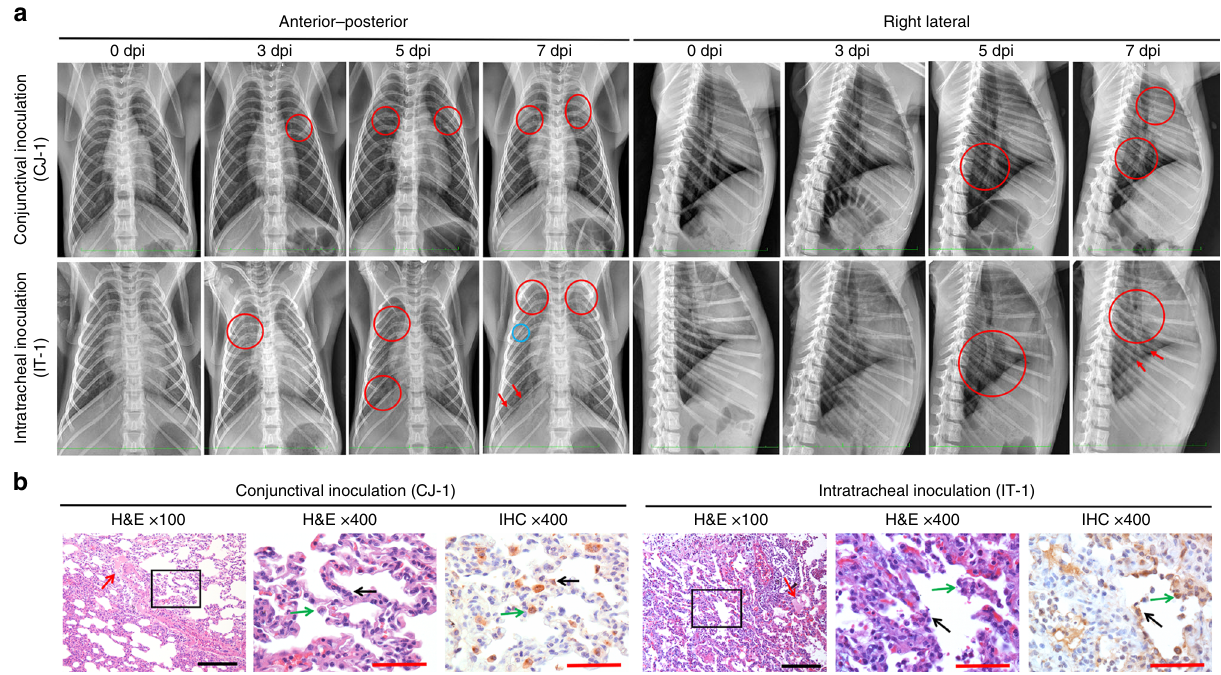
Fig. 3 Comparison of lesions in the lungs of CJ-1 and IT-1. Anterior – posterior and right lateral chest radiographs ( a ) were collected from rhesus macaques prior to SARS-CoV-2 inoculation (day 0) and at 3, 5, and 7 dpi. Areas of interstitial in fi ltration, indicative of pneumonia, are highlighted (red circle); obscure costophrenic angles (red arrows) and patchy lesions (blue circle) are also shown. The histopathological and immunohistochemical observations in the lungs are shown ( b ). Both macaques exhibited interstitial pneumonia with a thickened alveolar septum; the in fi ltration of in fl ammatory cells, mainly lymphocytes and macrophages; and some amount of exudation (red arrows) in the alveolar cavities at 7 dpi. Infection via the conjunctival route caused relatively mild pneumonia. Sequential sections were stained by H&E and subjected to IHC. Viral antigens were observed primarily in the alveolar epithelia (black arrows), along with detached degenerative cellular debris (green arrows). H&E-stained sections are shown at ×100 magni fi cation and magni fi ed at ×400 magni fi cation (black frame). The IHC image shows the same fi eld outlined in black at ×400 magni fi cation. Black scale bar = 100 µ m, red scale bar = 50 µ m. Data ( b ) are representative of three independent